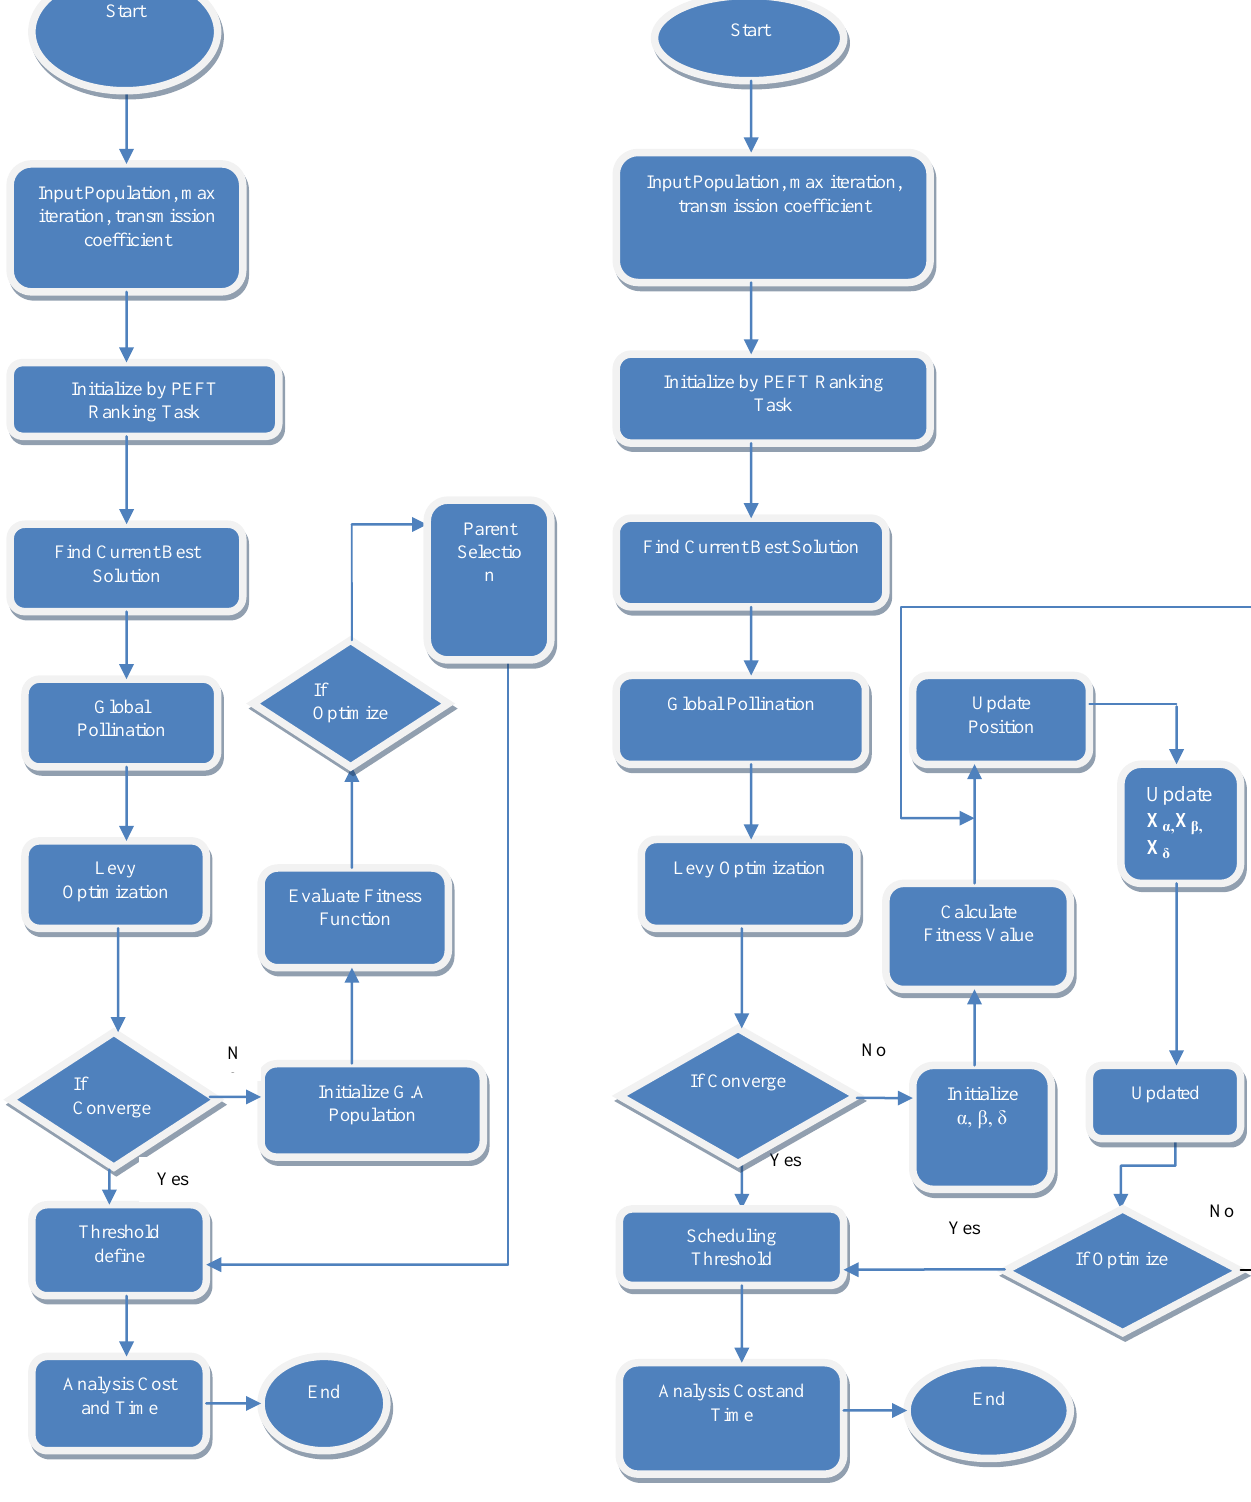
Figure 1. Existing FPA_GA optimization algorithm Figure 2. FPA_GWO hybrid optimization proposed